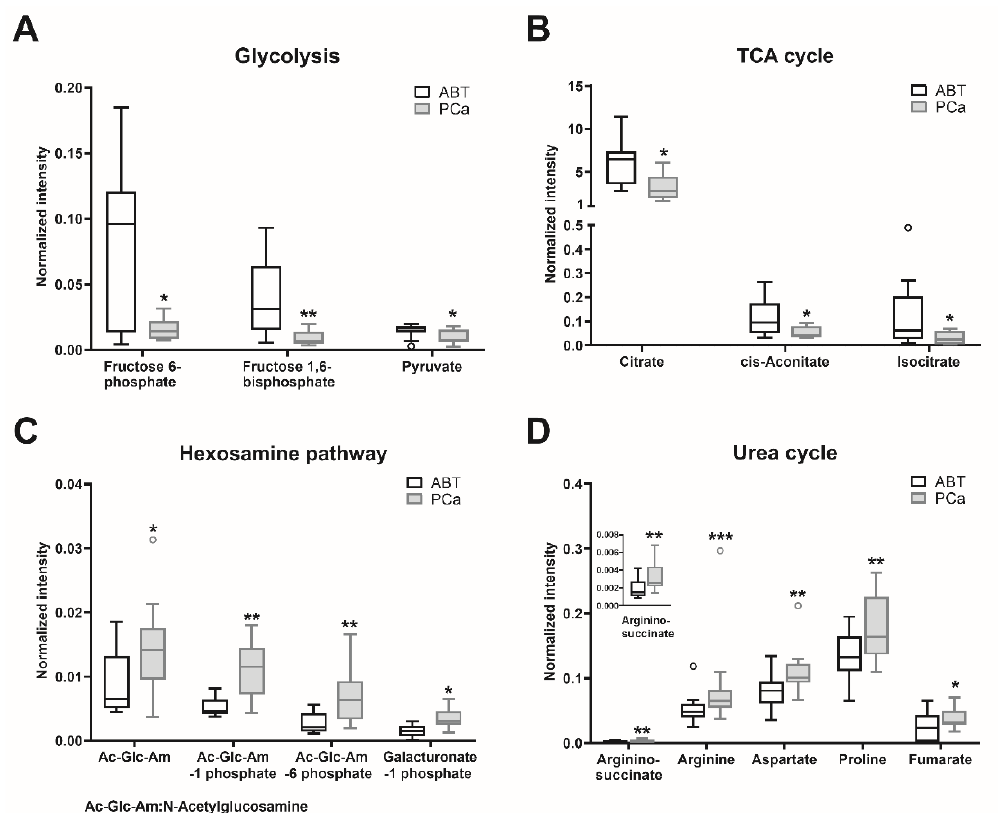
Figure 3. Major metabolites with significant di ff erences between PCa and ABT. Metabolites of prostate cancer (PCa) and adjacent benign tissue (ABT) were measured using CE–MS and LC–MS. Statistical significance was calculated using Wilcoxon signed-rank test and was considered as p < 0.05. * p <